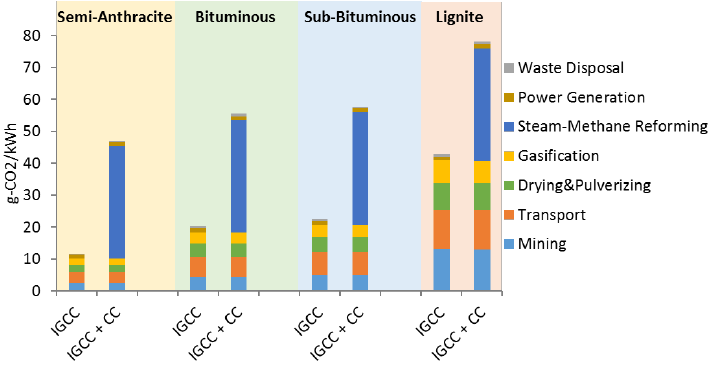
Figure 6. Life cycle carbon emission factors without accounting for the combustion of power plant fuel. (CC denotes carbon capture). Table 11. Lifetime coal requirement (Unit: Mt).